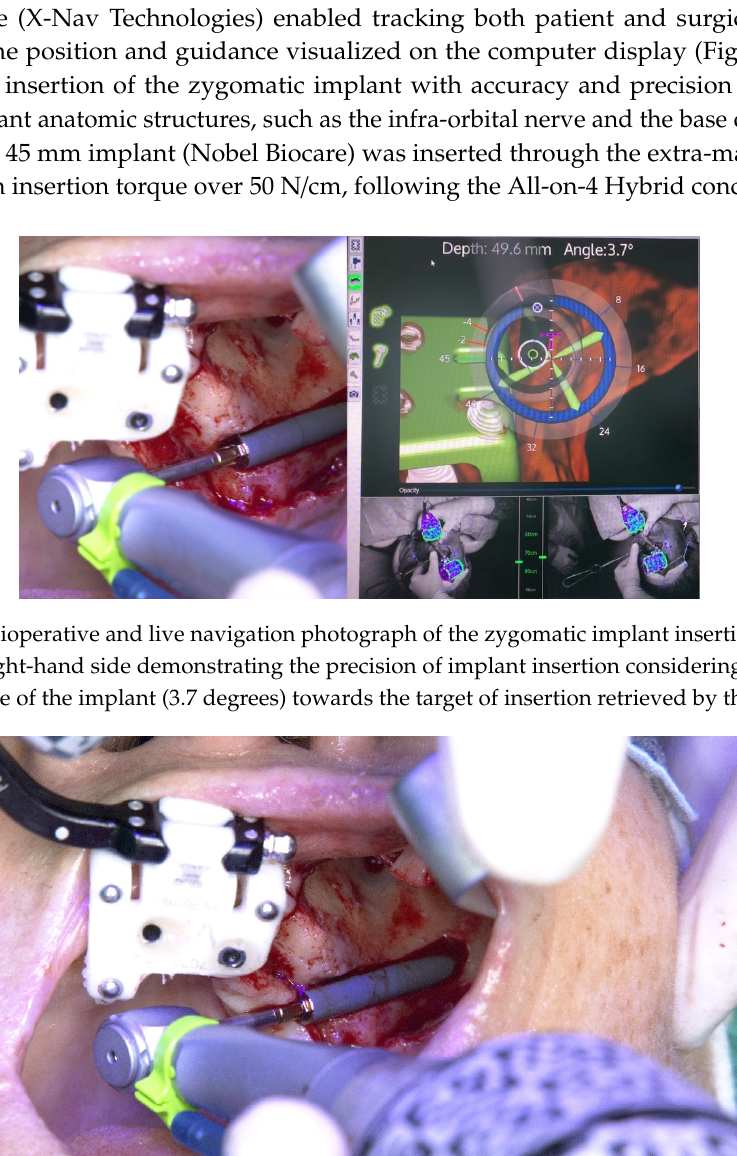
Figure 29. Perioperative photograph immediately after insertion of the zygomatic implant for completion of the All-on-4 Hybrid concept design for the rehabilitation of the edentulous maxilla. A multi-unit abutment of 45° 6 mm of height (Nobel Biocare) was connected to the zygomatic implant (Figure 30).